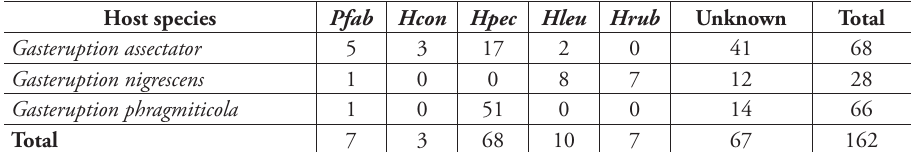
Table 2. Hosts of Gasteruption . Pfab – Pemphredon fabricii , Hpec – Hylaeus pectoralis , Hcon – Hylaeus confusus , Hleu – Hoplitis leucomelana , Hrub – Heriades rubicola